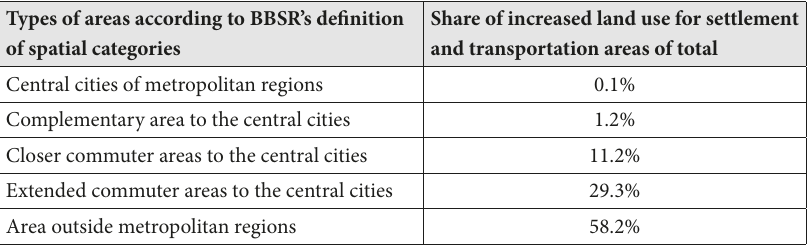
Table 1 Relative share of increased land take for settlement and transportation areas for different spatial categories in Germany from 2011 to 2016 (Source: Krüger et al. 2017,